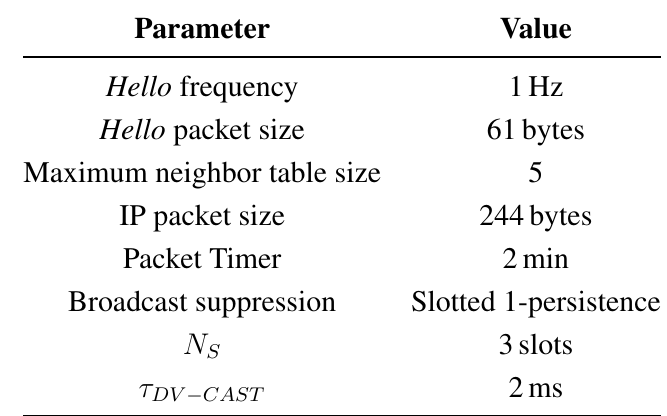
Table 7. DV-CAST configuration.